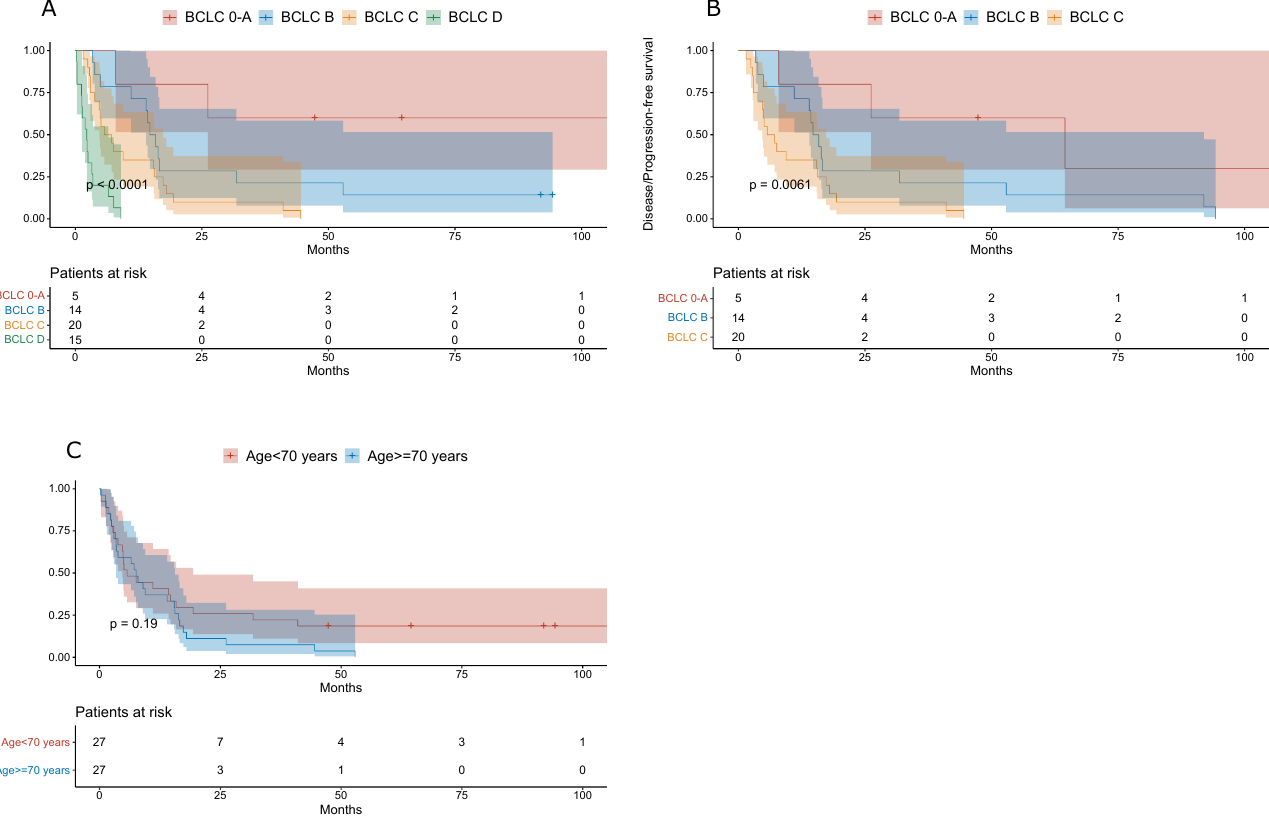
free survival between NAFLD- and other etiology-related HCC patients with BCLC B (Figure 3) or BCLC C (Figure